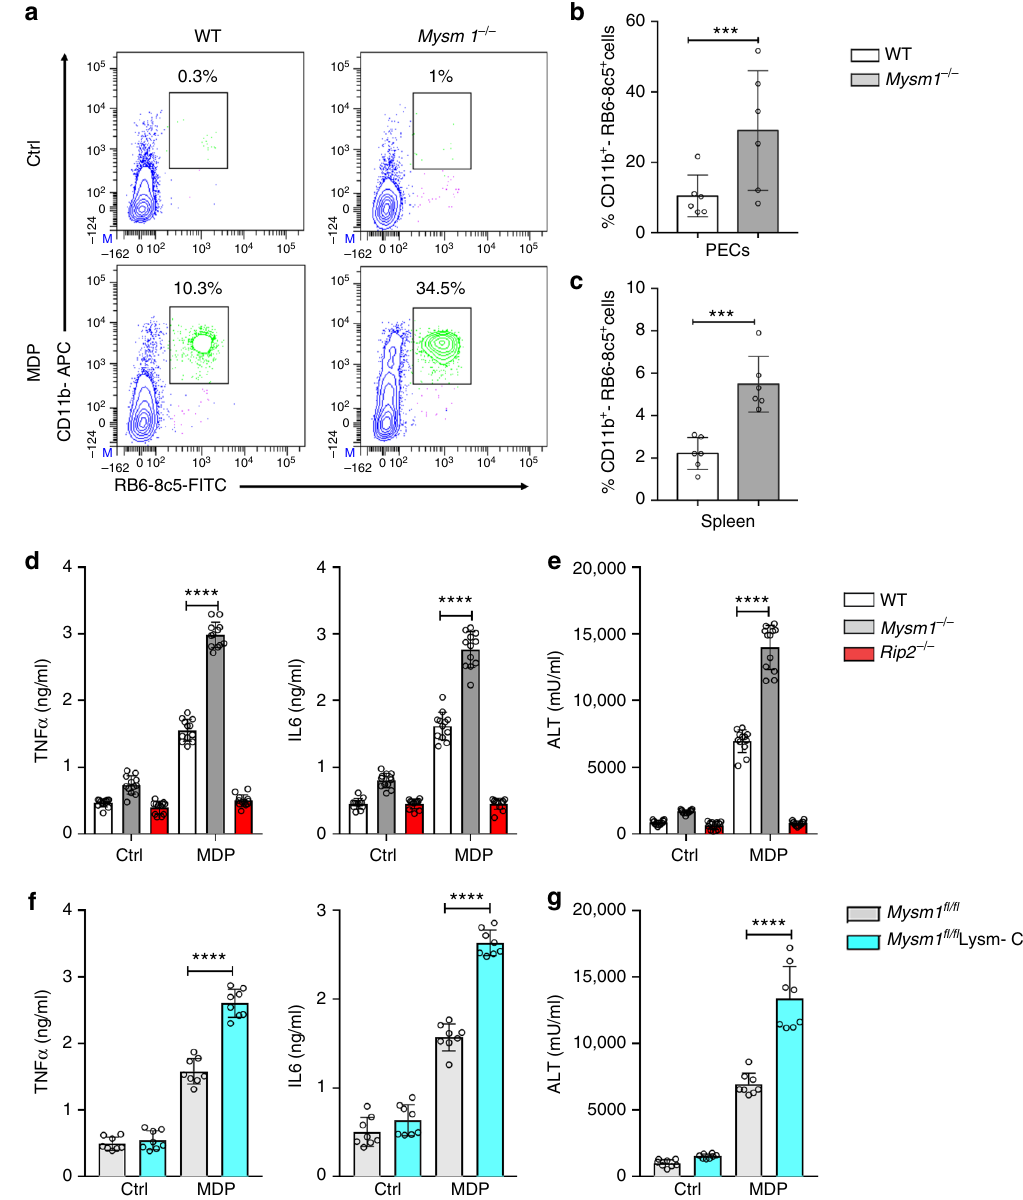
Fig. 7 MYSM1 suppresses NOD2-mediated systemic in fl ammation and liver injury. a Representative fl ow cytometry contour plots showing the recruitment of neutrophils (CD11b + , RB6-8c5 + ) into peritoneal cavities (PECs) of WT ( n = 6) and Mysm1 − / − ( n = 6) mice 6 h post administration of MDP (25 mg/ kg body weight) or control buffer (Ctrl). b – c Corresponding bar graphs showing the mean percentage of neutrophils in PECs ( b ) and spleen ( c ). d – e WT ( n = 12), Mysm1 − / − ( n = 12) and Rip2 − / − ( n = 12) mice were inoculated with GalN (1 g/kg body weight, via intraperitoneal (i.p) route 4 h prior to challenge with MDP (25 mg/ kg body weight, i.p) analysed 6 h later for TNF- α , IL-6 ( d ) and liver alanine aminotransferase (ALT) in the sera ( e ). f – g TNF- α , IL-6 ( f ) and ALT ( g ) in sera of Mysm1 fl / fl ( n = 8) or Mysm1 fl / fl LysM-Cre ( n = 8) mice challenged with GalN and MDP as in d – e . Each data point represents ( b-g ) an individual mouse. Data are shown as mean ± s.d.. **** p < 0.0001 determined by one-way analysis of variance (ANOVA) with Bonferroni ’ s multiple- comparison test. Data in b , c and f , g are from two independent experiments, ( d , e ), from three independent experiments. See Supplementary Figure 10 for gating strategy for the FACs data in panels ( a – c infections, while preventing a self-destructive in fl ammation. A focal point of NOD2 signaling is RIP2, a scaffolding protein that nucleates the recruitment and activation of downstream signaling proteins leading to NF-kB- and MAPK-mediated cellular responses. Whereas the ubiquitination of RIP2 is well acknowl- edged to lie at the heart of NOD2 signaling, the precise nature of the ubiquitin modi fi cations involved and how they are regulated to ensure a coordinated activation and resolution of NOD2- mediated in fl ammation remains poorly de fi ned. This study